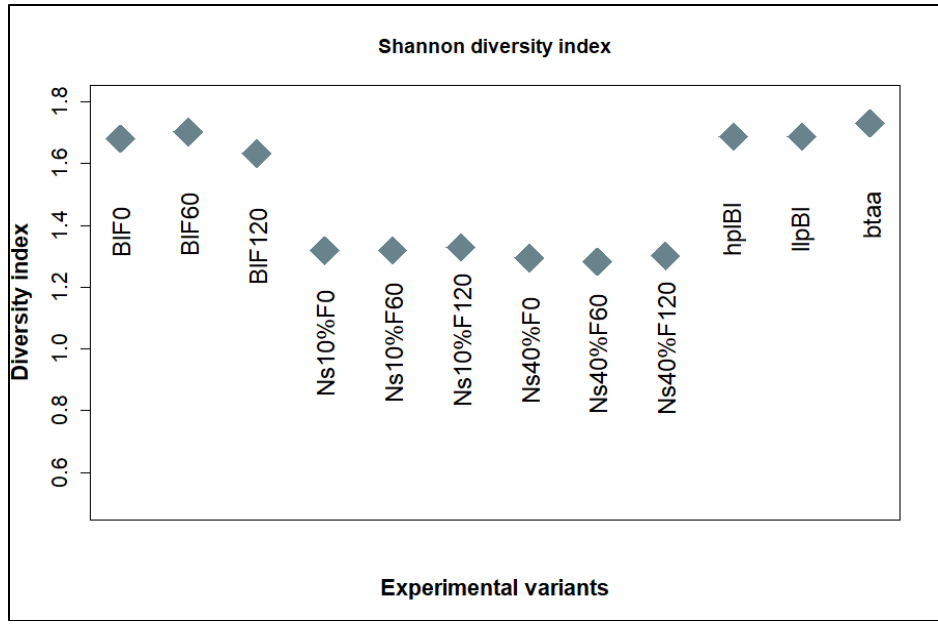
Figure 4. Values of Shannon diversity computed for the 12 experimental variants.